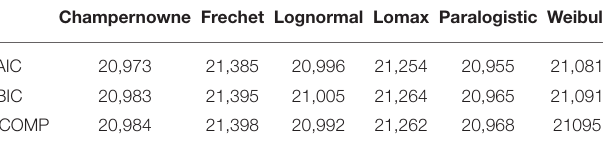
3), sample size 100. =